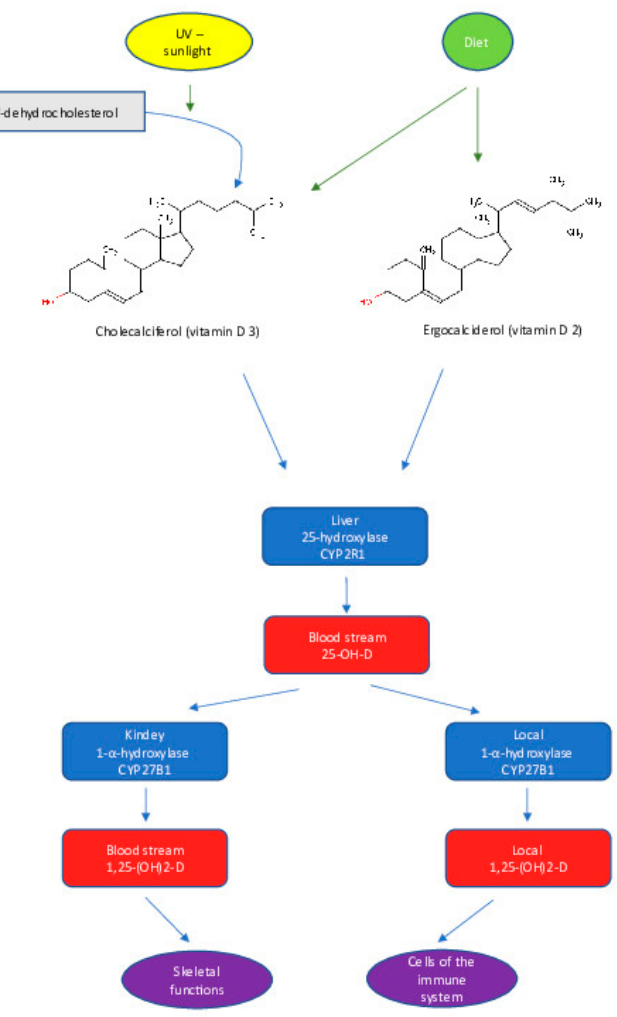
Figure 1. Vitamin D—sources and metabolism.